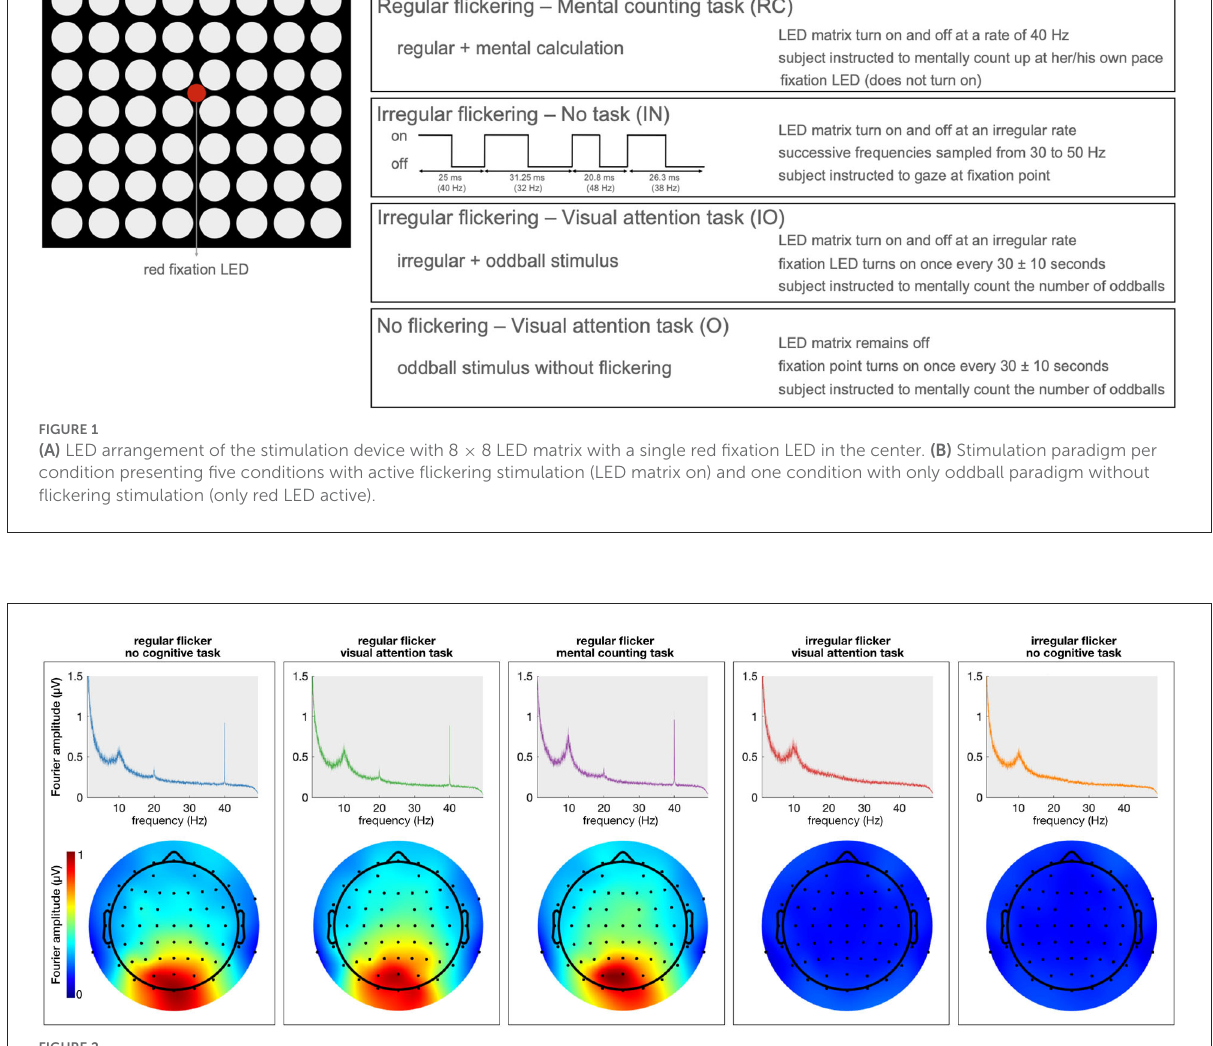
FIGURE2 Average (across subjects) frequency spectrum showing gamma entrainment for each of every five stimulation conditions. The (top) panel shows the amplitude of the 40 Hz frequency in the frequency spectrum presented in µ V and the (bottom) panels show the spatial distribution of 40 Hz across the scalp. As one can see, unlike regular stimulation conditions, there is no increase in 40 Hz amplitude in irregular stimulation conditions. As to spatial distribution of the entrainment, as expected, it was the most prominent in the occipital area of the scalp for all regular